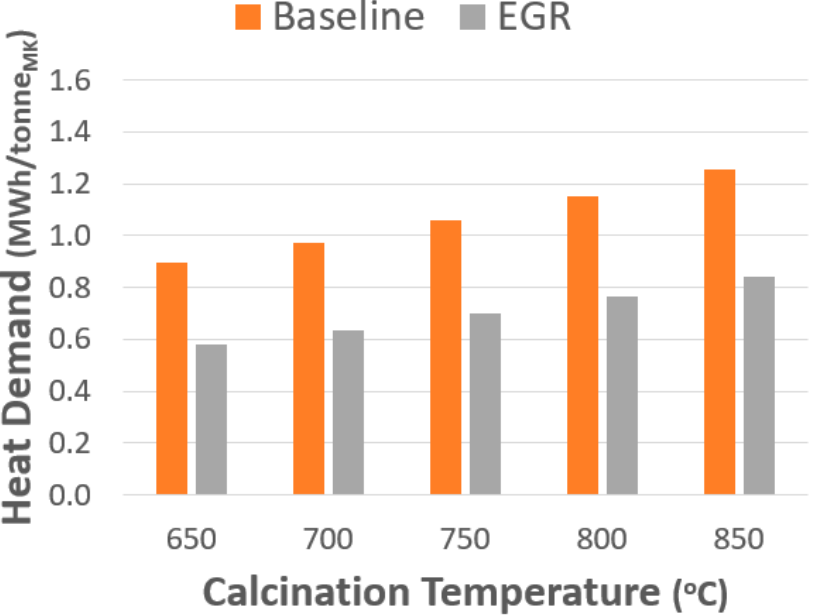
Figure 4. Calculated MK production process heat demand (MWh/tonne MK ). Impact of calcination temperature. (Fuel: NG; reference moisture content of kaolinite: 15%